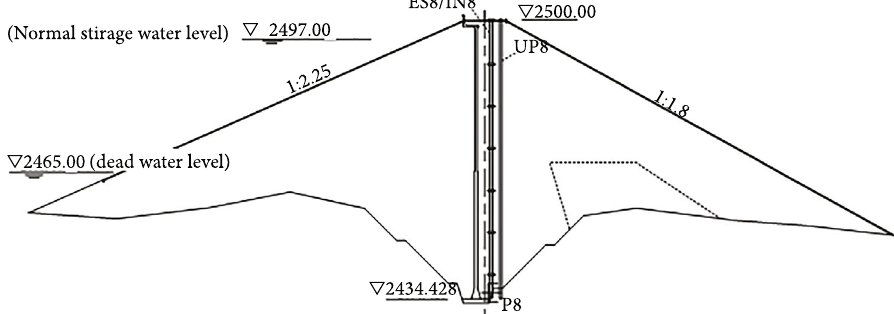
Figure 4: Distribution map of seepage monitoring instrument in the cross section 0 +290.